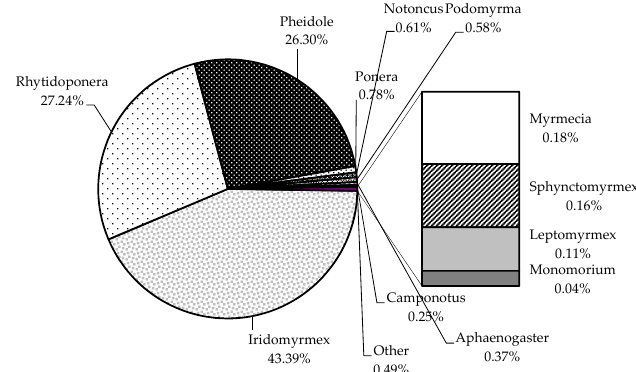
Figure 5. Proportion of mean ant abundance (mean total per field) recorded at all seasons, land use types and agricultural management regimes during the study period. Each data point was the total abundance of 20 pitfall traps per field, with each field (n = 24) sampled on eight occasions, once in each season and repeated in the following calendar year. The mean for a specific treatment was based on the number of replicates for that particular grouping i.e., grazing (n = 64) or cropping (n = 128). Total number of sampling occasions = 192. Ant numbers were also much higher under grazing than cropping land use types (F 1,1 = 21.087, p = 0.0001) (Figure 2, Table 4). Higher ant numbers, especially Iridomyrmex (F 1,5 = 15.312, p = 0.0001) and Pheidole (F 1,5 = 5.767, p = 0.0040), were recorded under native pasture (NP) (Figure 6a,b) compared with the other agricultural management regimes (Table 4). Pheidole were more abundant in the grazing land use type compared with cropping (Table 4). Nevertheless, high numbers of Pheidole were recorded in LFZ, in summer, comparable to those numbers recorded under grazing land use type (Table 4, Figure 6b). In contrast to Iridomyrmex and Pheidole , Rhytidoponera showed no seasonal preference and were equally abundant over summer, autumn and spring with variable numbers recorded over winter (Table 3, Figure 6c). There were no clear statistical differences in activity of Rhytidoponera between cropping and grazing land use types (Table 4). However, low numbers of Rhytidoponera were recorded for native pasture (NP) and long fallow conventional tillage (LFC) compared with other cropping and grazing systems (IP, SFZ, SFC, LFZ) (Table 4, Figure 6c).